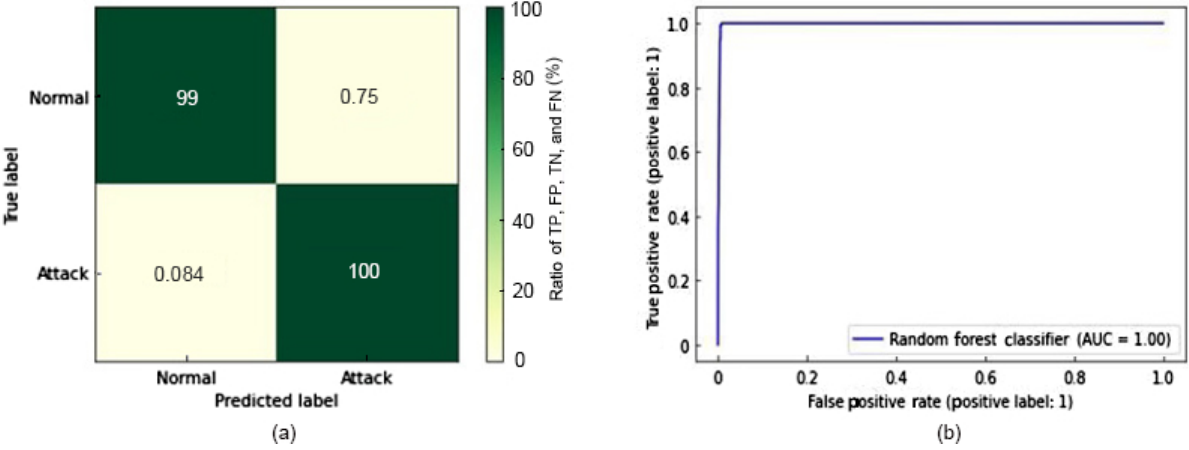
Fig. 14 Confusion matrix and ROC curve of RF-PCC on the NF-UNSW-NB15-v2